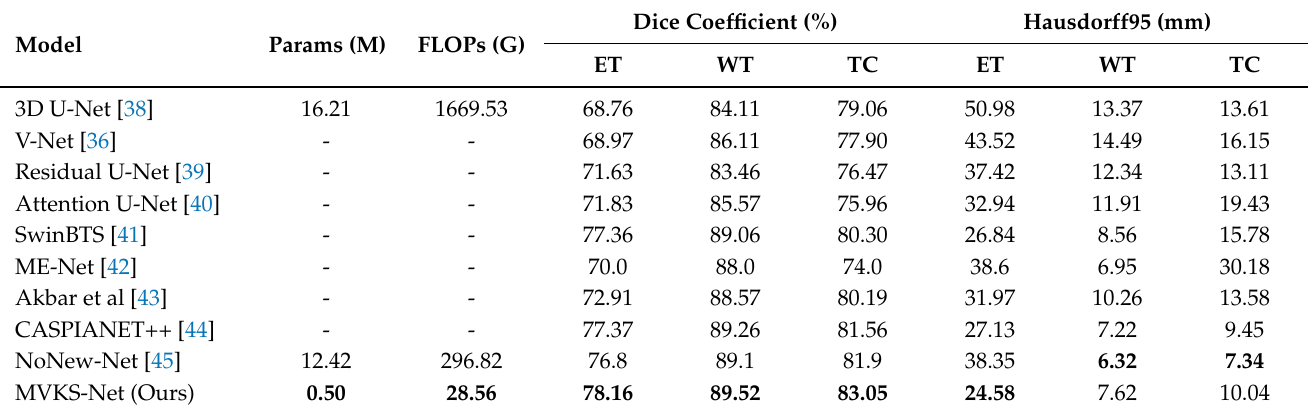
Table 5. Comparison of segmentation results of various non-lightweight networks on the BraTS2020 validation set. A (-) denotes that the results are not